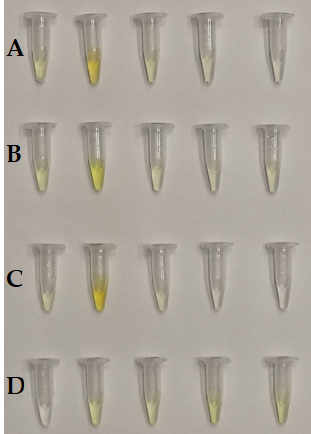
Figure 4. Successive samples (0.5 mL) collected after passing through BioGel P-150 : ( A ): TY-Ag, ( B ): BSA-TY, ( C ): BSA-TY-Ag, ( D ): TY.